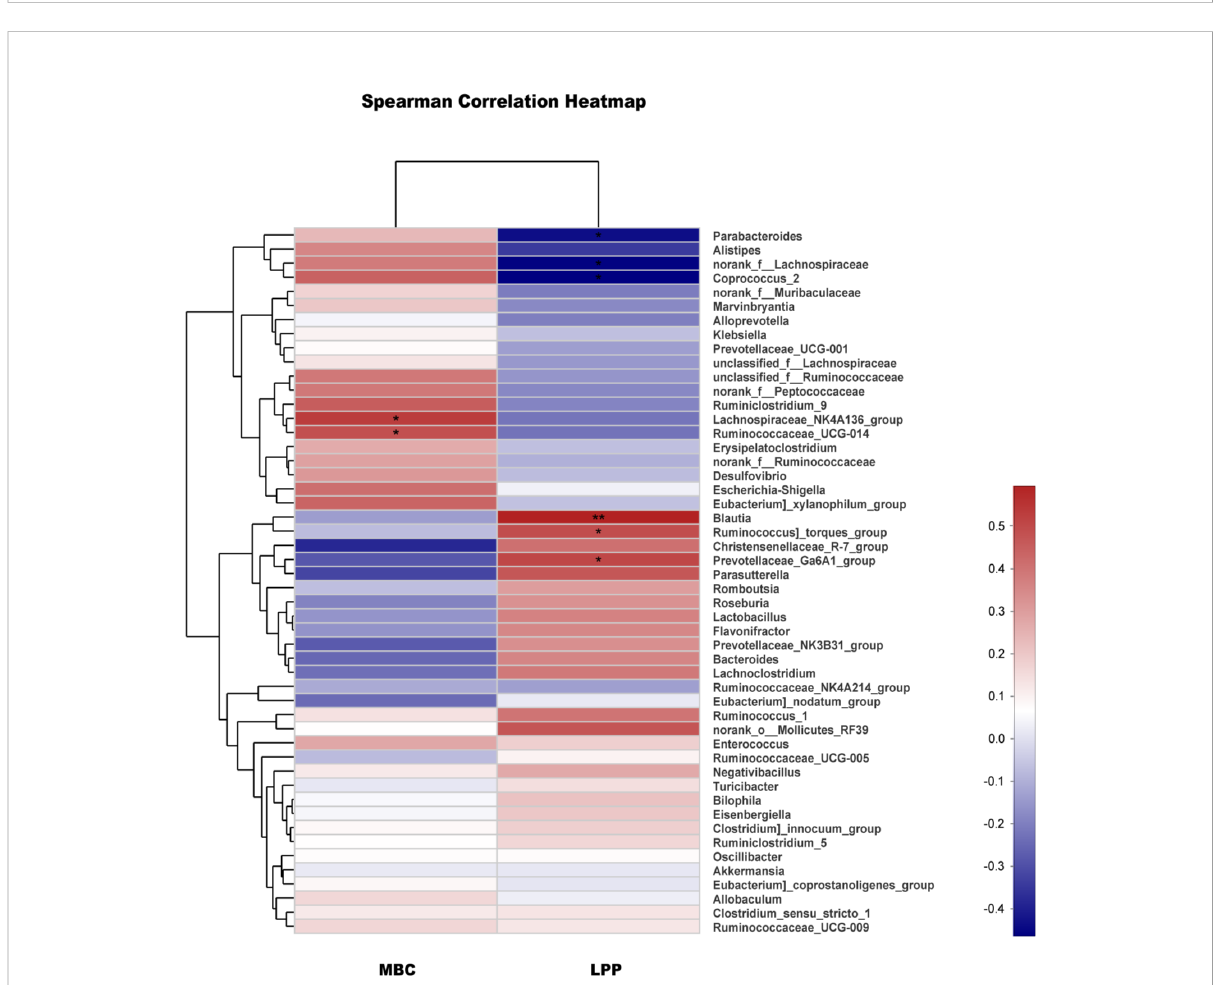
FIGURE 5 Correlation analysis between urodynamics and different genera. Correlation analysis between MBC, LPP and the major genera. The analysis was conducted using Spearman ’ s test. Red represents a positive correlation, and blue represents a negative correlation; the deeper the color is, the stronger the correlation (*0.01< P ≤ 0.05, **0.001< P ≤ 0.01).